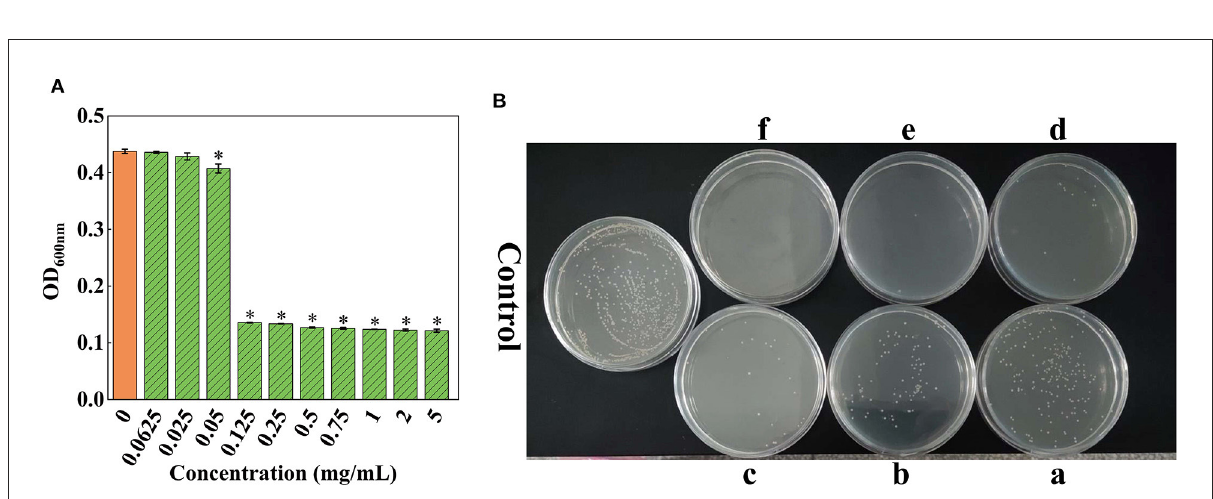
FIGURE2 MIC and MBC of SSPE for E. coli . (A) Effects of solutions with different SSPE concentrations on the optical density (OD) of E. coli solution, * indicates significant difference between treatment group and control group in OD ( p < 0.05). (B) Effects of solutions with different SSPE concentrations on the viable count of E. coli in MHB solid medium. a: 0.5 mg/mL, b: 0.75 mg/mL, c: 1 mg/mL, d: 2 mg/mL, e: 4 mg/mL, f: 5